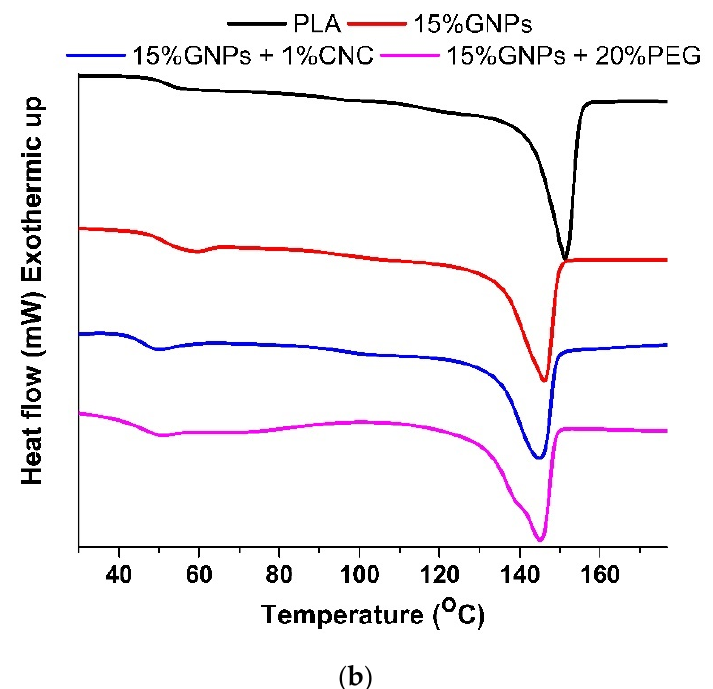
Figure 4. ( a ) DSC curves of the PHA films with different additions by mass: graphene nanoparticles (GNPs), cellulose nanocrystals (CNC) and polyethylene glycol (PEG). ( b ) DSC curves of the PLA films with different additions by mass: graphene nanoparticles (GNPs), cellulose nanocrystals (CNC) and polyethylene glycol (PEG). Table 2. Summary of results obtained by physical characterization of PHA and PLA composites with different additions (GNPs, CNC and PEG).